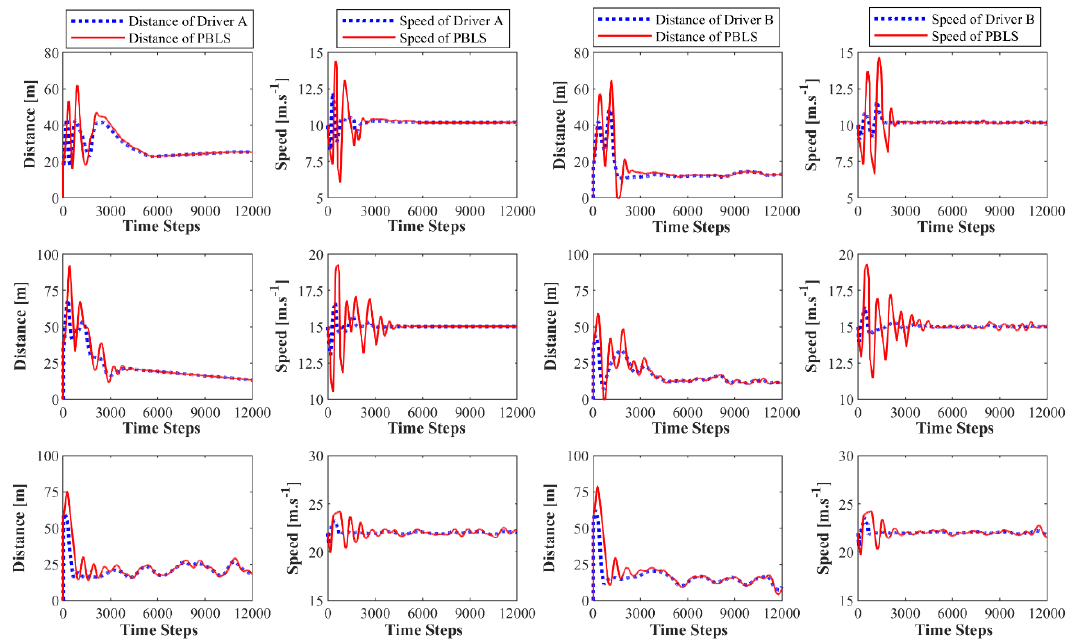
Figure 4. Learning curves for the distance and the speed of two drivers: the figures in the first row are for the low speed scenario; the figures in the second row are for the medium speed scenario; the figures in the third row are for the high-speed scenario.